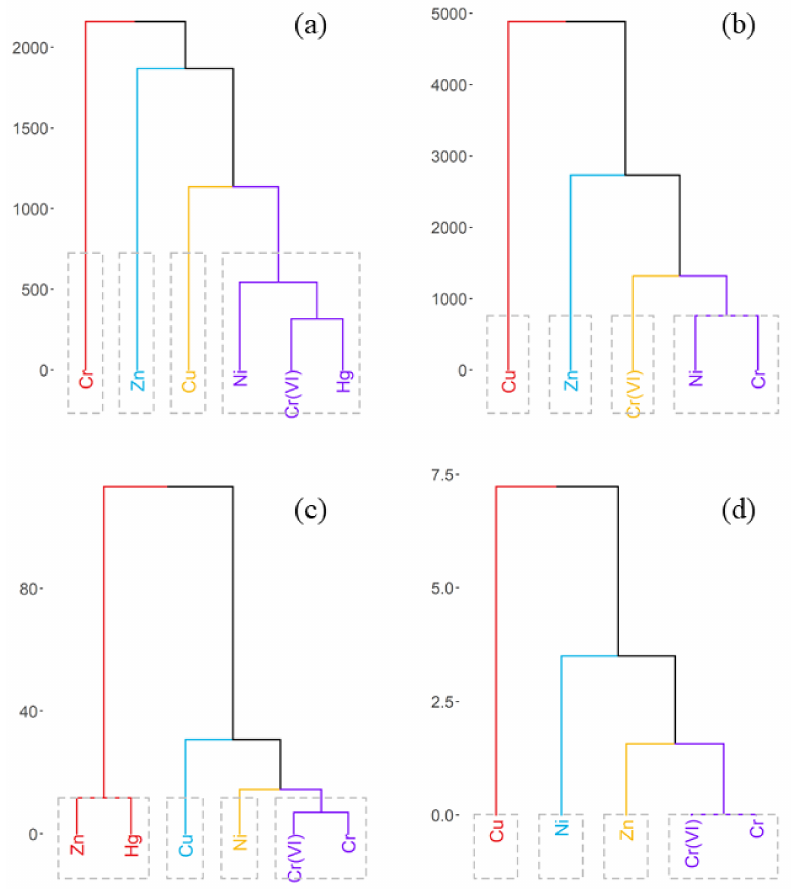
Figure 6. Cluster analysis of the heavy metals in soil for ( a ) Factory A, ( b ) Factory B; ( c ) in ground- water for Factory A; ( d ) for Factory